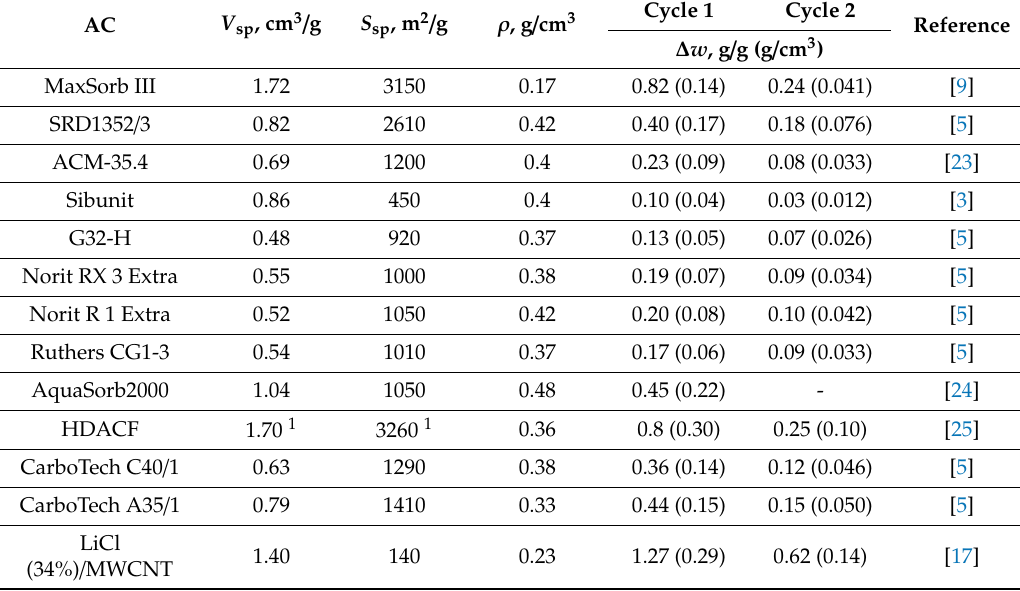
Table 1. Texture characteristics of the studied carbons and specific mass of methanol exchanged in the HeCol cycles